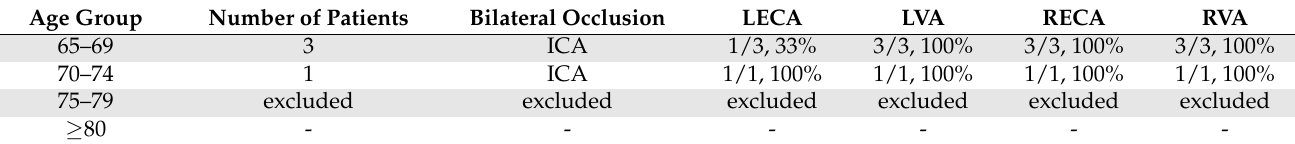
Table 6. Pathways of collateral circulation in patients with bilateral ICA occlusion.